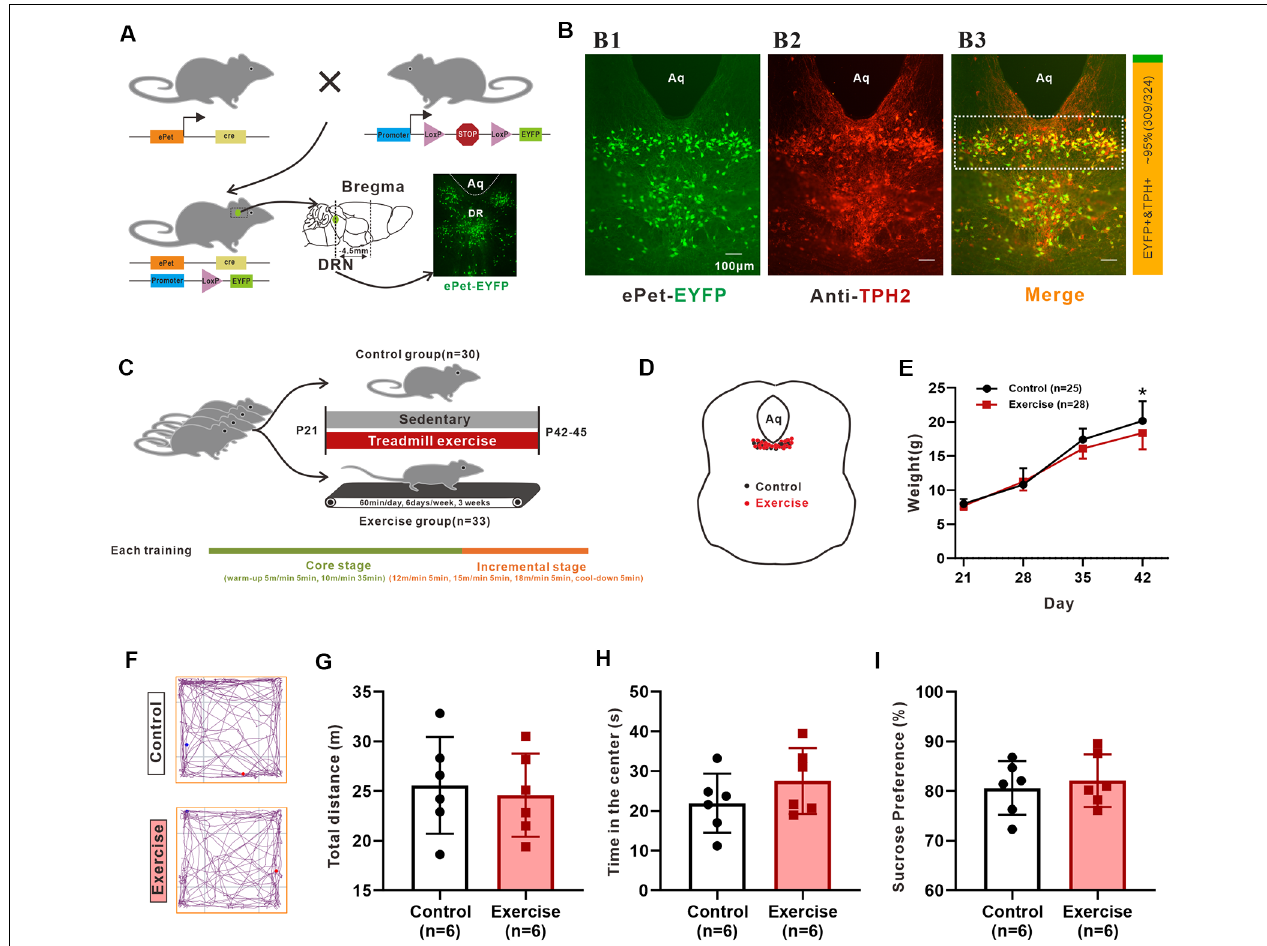
FIGURE 1 | The reliability of animal model and experimental design. (A) Schematic representation of the generation of the transgenic ePet-EYFP mice. The Serotonin (5-HT) neurons in the dorsal raphe nucleus (DRN; about − 4.5 mm apart from bregma) were labeled with enhanced yellow fluorescent proteins. (B) Colocalization (B3) of ePet-EYFP (B1) and TPH2 ( B2 ; TPH2 1:200, ab184505, Abcam) in DRN. The ratio of the number of TPH2-labeled EYFP-positive neurons (orange color, double labeling) to the number of EYFP-positive neurons (both green and orange colors) in the DRN (shown as dotted box in B3 ) were counted manually. The statistical results are shown in a bar chart on the right (about 95%, 309/324, mice: n = 3). (C) Sixty-three mice (P21) were randomly divided into control group and treadmill exercise group. Control group mice remained sedentary ( n = 30), and treadmill exercise mice completed 60 min treadmill exercise each day (6 days/week) for a period of 3 weeks ( n = 33). Each training session was divided into two stages (core stage and incremental stage). The core stage took a total of 40 min (warm-up 5 m/min for 5 min, 10 m/min for 35 min). The incremental stage took a total of 20 min (12 m/min for 5 min, 15 m/min for 5 min, 18 m/min for 5 min, cool-down for 5 min). (D) Location of neurons patched for electrophysiological and morphological analysis. (E) Weight of control ( n = 25) and treadmill exercise group ( n = 28) mice at P21, P28, P35, and P42. Three weeks of exercise significantly decreased the body mass of mice ( p = 0.036). (F) The representative trajectory maps of each group. There was no significant difference either in total distance (G) or time in the center (H) in the Open-Field Test (OFT; p = 0.715, p = 0.247, respectively). (I) There was no significant difference in sucrose preference ( p = 0.638). * p <